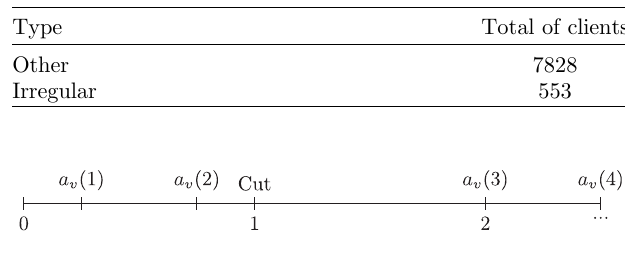
Figure 1. Scheme of the organization of the ordered values ; on the left those that indicate greater risk, on the f a v ð i Þg 7828 i ¼ 1 right those of lower risk. Cut = 1 indicates the threshold given by the